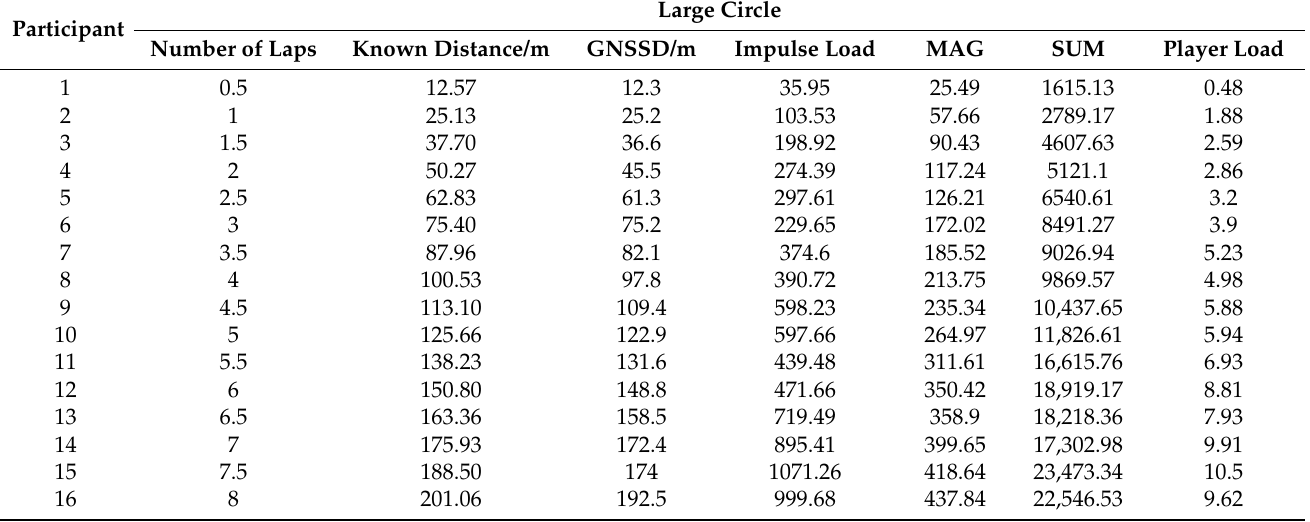
Table 6. Details for each trial include laps and known distance completed around the large circle course, GNSS measured distance, and all accelerometry derived